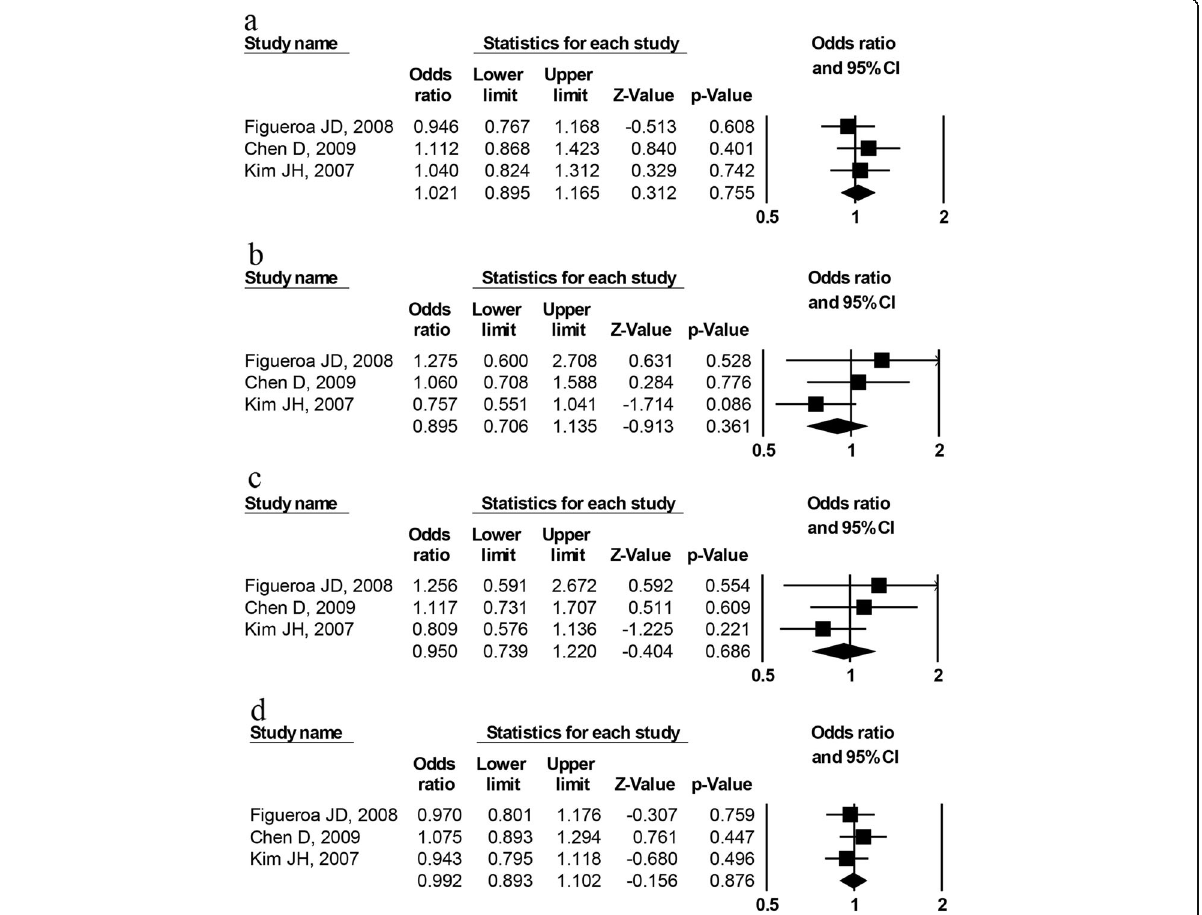
Fig. 5 Forest plot for AhR rs2074113 polymorphism and the overall cancer risk. a Dominant model (AA+CA vs. CC), b recessive model (AA vs. CA+CC), c codominant model (AA vs. CC), and d allelic model (A vs.